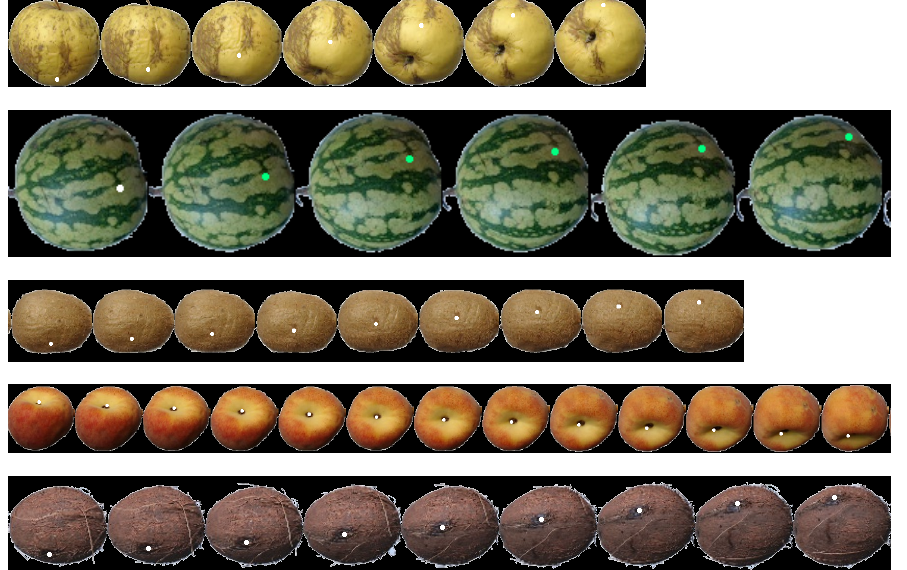
Figure 28. Examples of point tracking of fruits in the Fruit-360